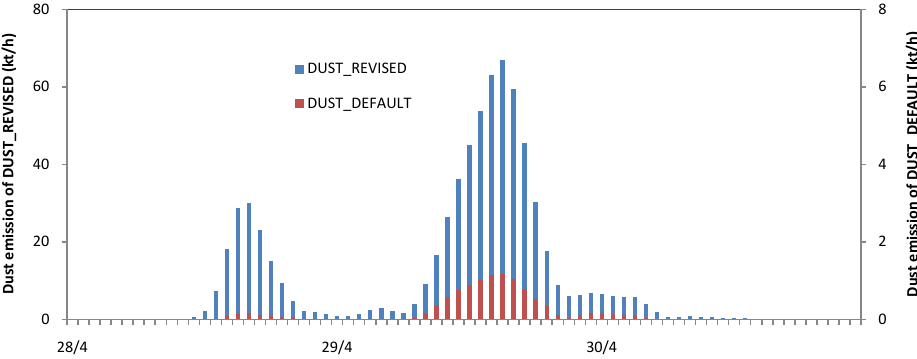
Fig.5. The temporal variation of dust emissions Fig. 5. The temporal variation of dust